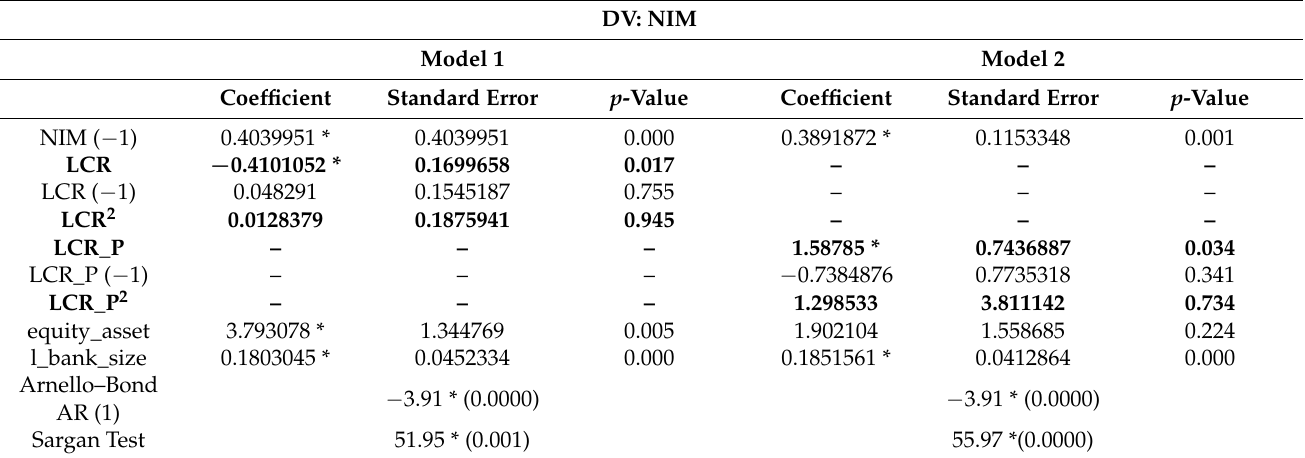
Table 4. Dynamic Panel Data Model (Models 1 and